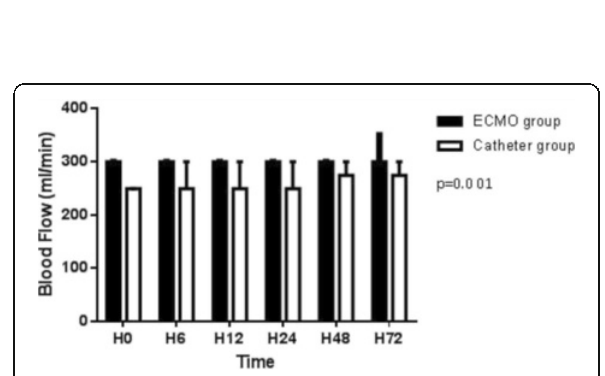
Fig. 132 (abstract A332). Effective blood flow during CVVH (median with IQ)